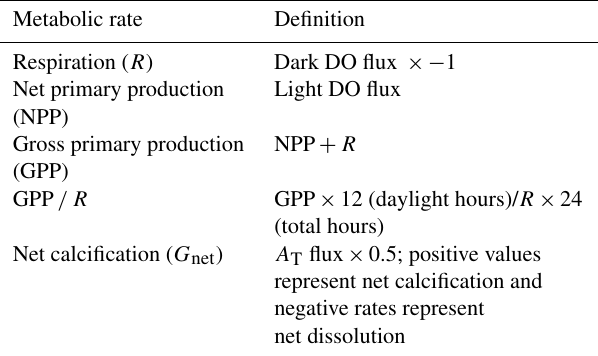
Table 2. The equations used in this study to calculate rates of sed- iment metabolism based on measured fluxes in dissolved oxygen (DO) and total alkalinity ( A T ; Eyre et al.,